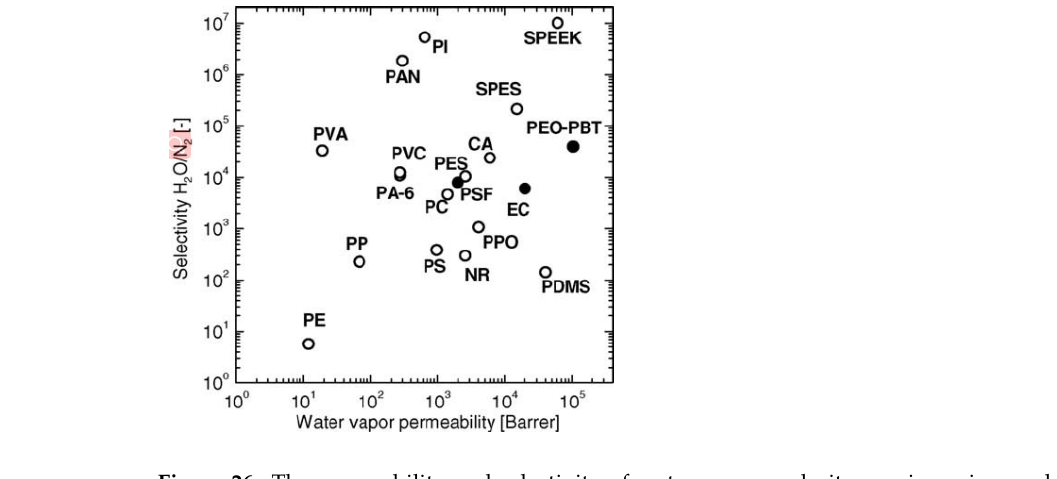
Figure 26. The permeability and selectivity of water vapor and nitrogen in various polymers at 30 °C [91].